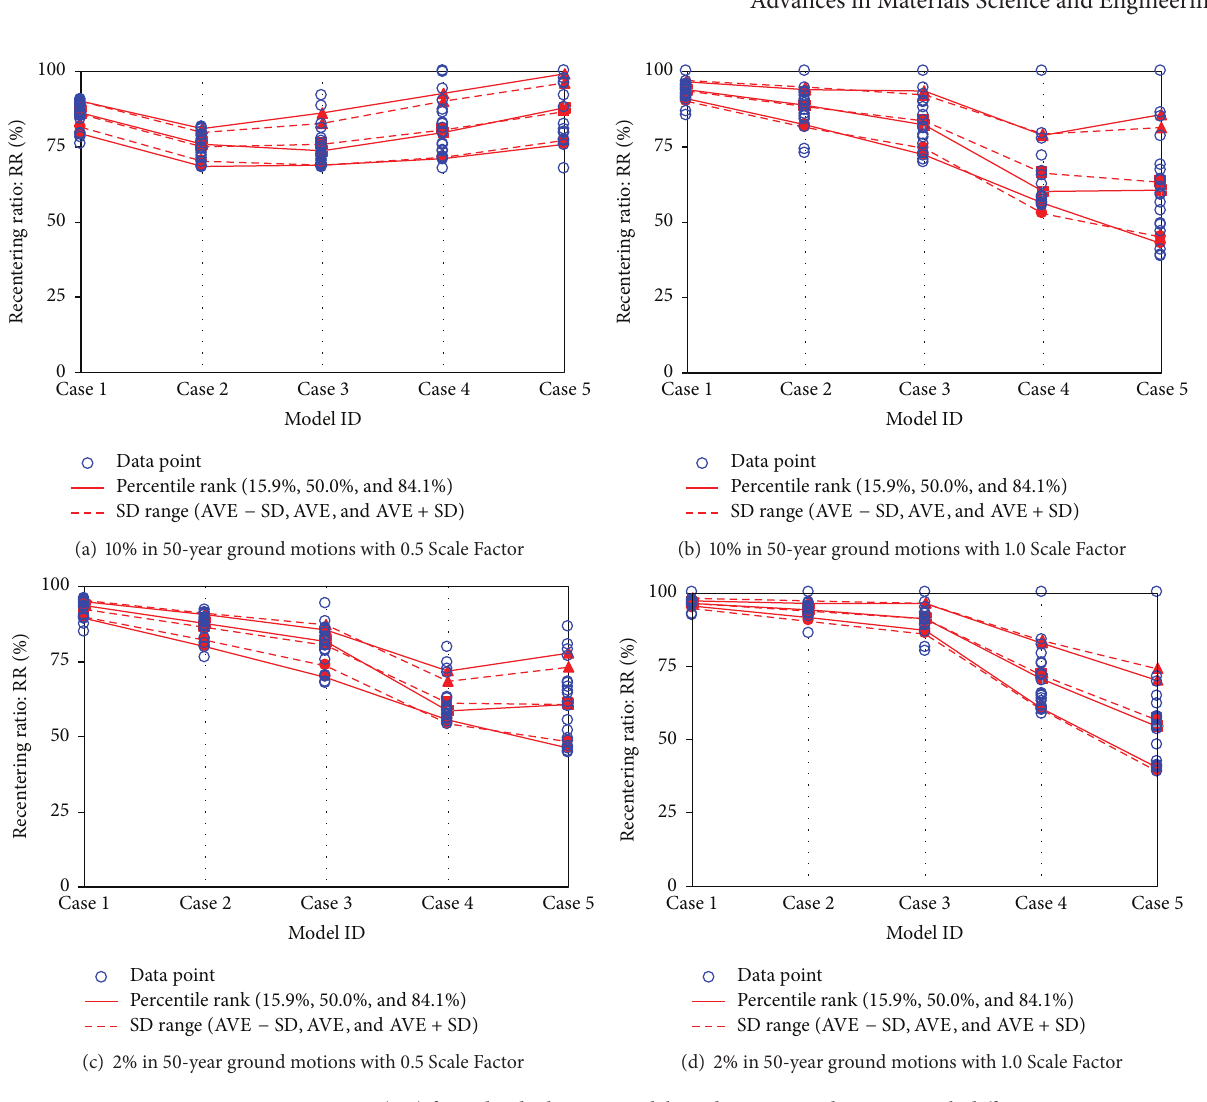
Figure 15: Recentering ratios (RR) for individual SFDB models under 40 ground motions with different